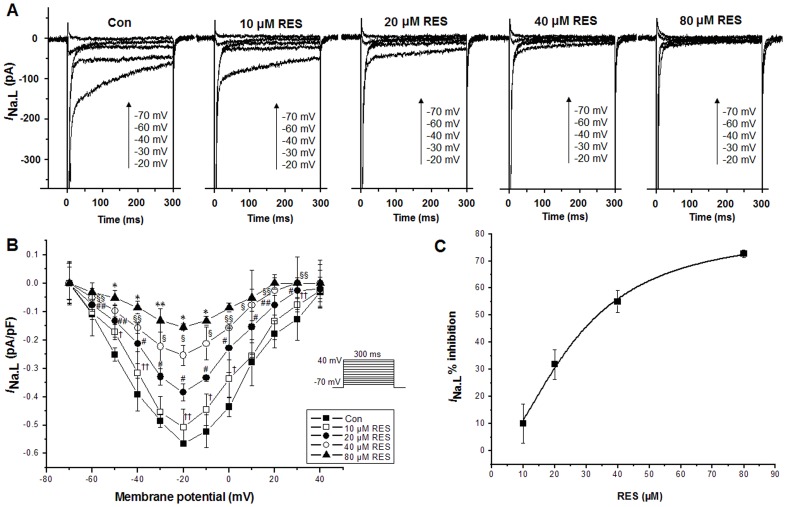
Effects of resveratrol (RES) on I
Na.L under control condition (Con) in rabbit ventricular myocytes.
A. 10, 20, 40 and 80 µM resveratrol decreased the amplitude of I
Na.L in a concentration dependent manner. B. Effect of resveratrol (10, 20, 40 and 80 µM) on the current-voltage relationship. C. The inhibition amounts of 10, 20, 40 and 80 µM resveratrol on I
Na.L. Values are expressed as mean ± SD, n = 8 cells/group. †P<0.01, ††P<0.05 versus control group; #P<0.01, ##P<0.05 versus 10 µM resveratrol group; §P<0.01, §§P<0.05 versus 20 µM resveratrol group; *P<0.01, **P<0.05 versus 40 µM resveratrol group.